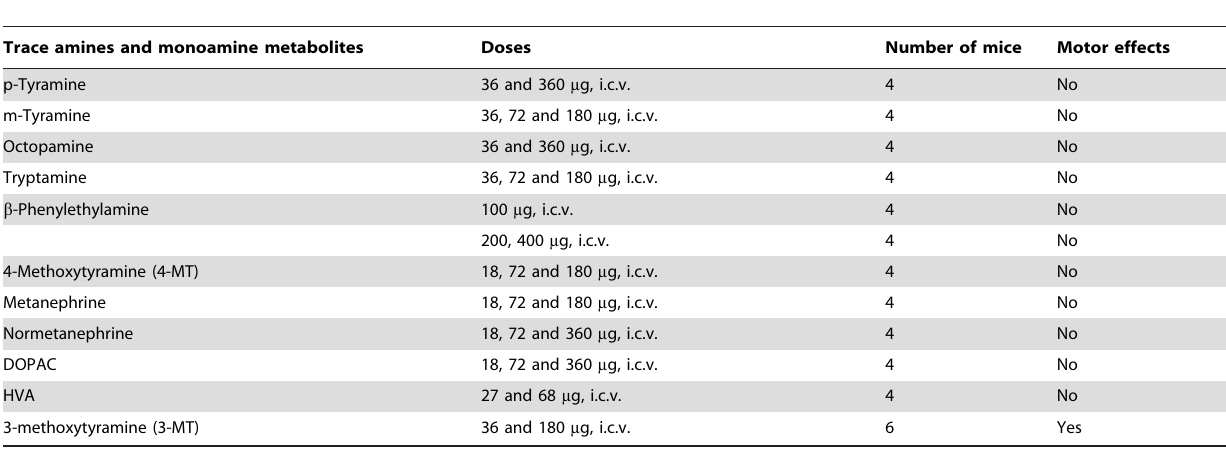
Table 1. Trace amines and monoamine metabolites tested in DDD mice.